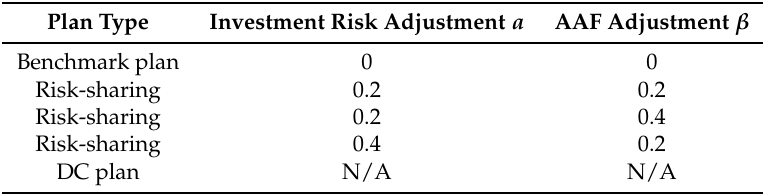
Table 1. Plan parameters for the risk-sharing